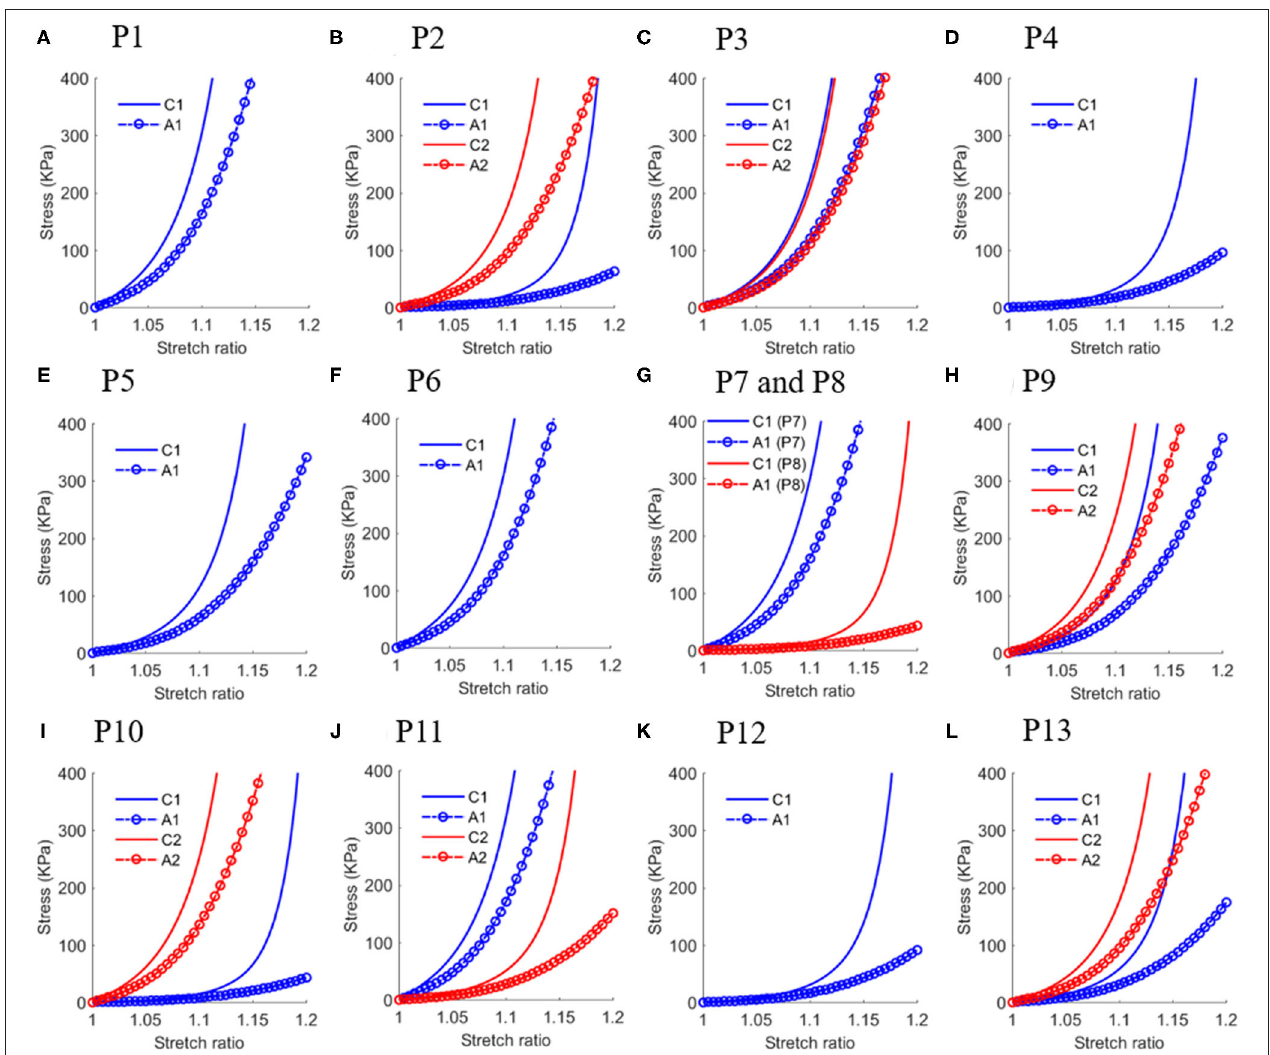
FIGURE 4 | Stress-stretch ratio curves in circumferential and axial directions of in vivo plaque material properties with each sub-figure (A–L) plotted the curves for one patient except (G) plotted curves for P7 and P8 to save space. Abbreviation: C1 - Circumferential direction at Site 1; A1 - Axial direction at Site 1; C1 - Circumferential direction at Site 2; A2 - Axial direction at Site